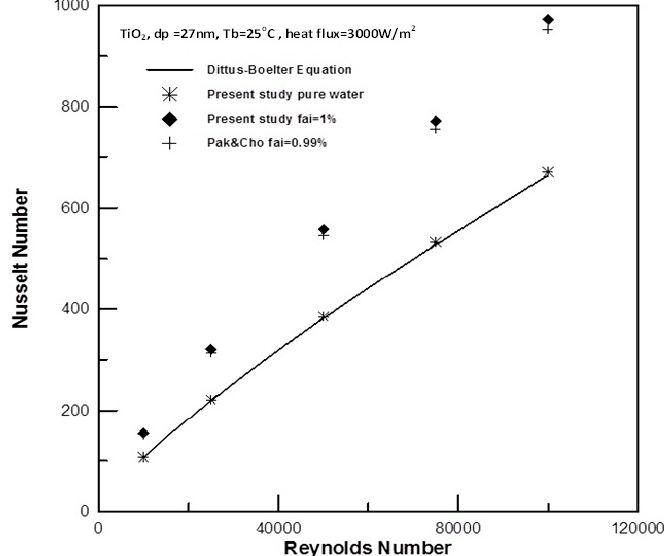
Figure 6. Comparison CFD results of Nu with Pak and Cho experimental data [7].